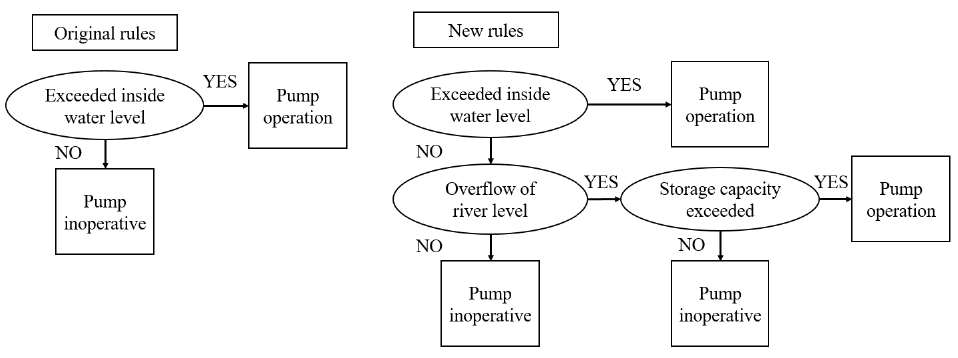
Figure 6. Original and new rules of the drainage pump